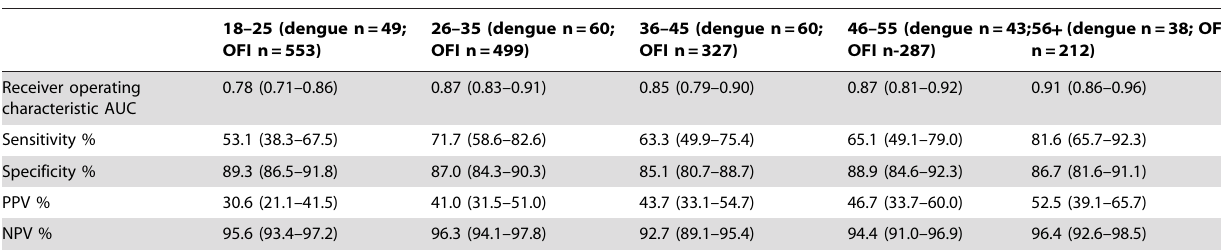
Table 9. Age-specific features of using fever and leukopenia for probable dengue